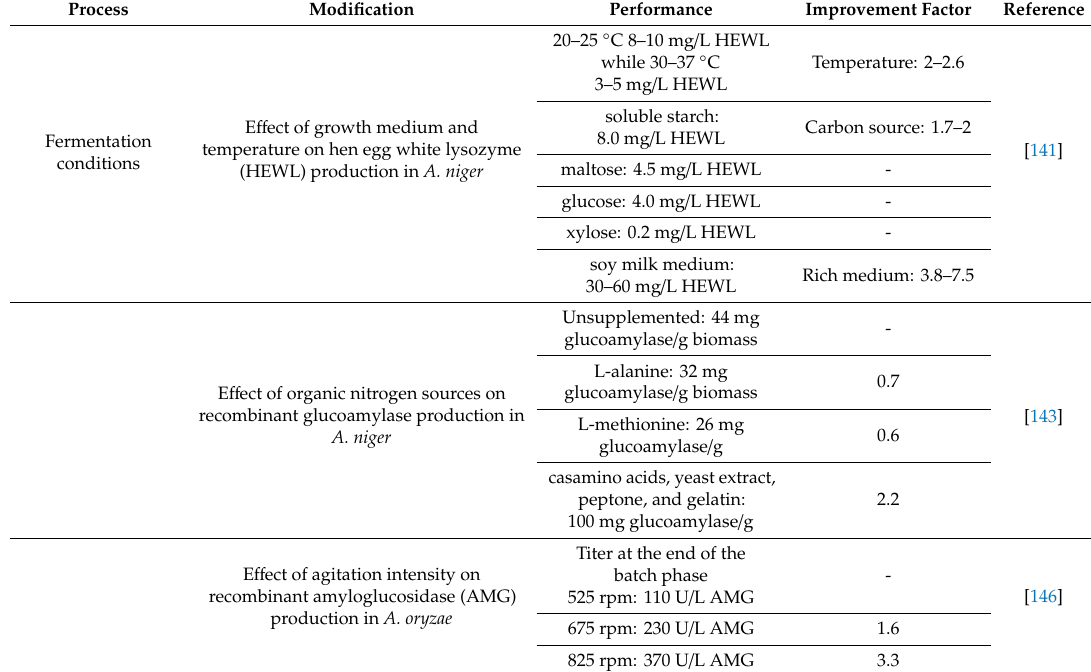
Table 12. Approachesforimprovingrecombinantproteinproductionthroughbioprocessingmodifications. Process Modification Performance Improvement Factor Reference